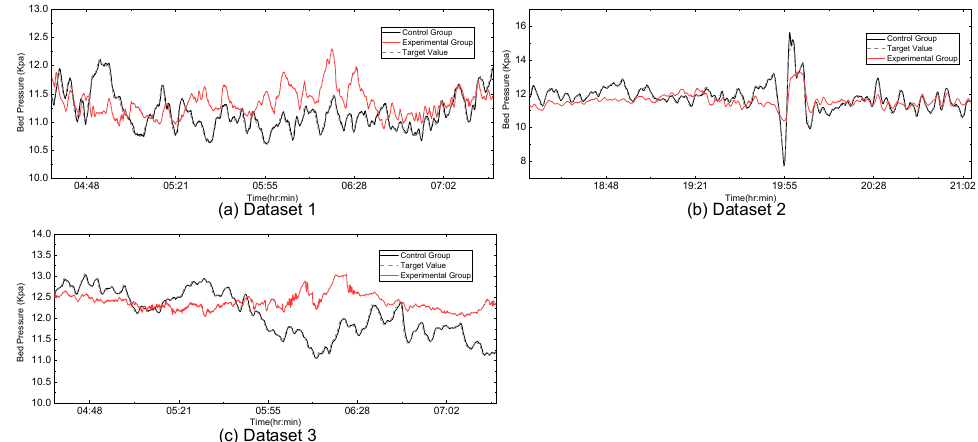
Figure 11. The prediction comparison diagram of the differential prediction method.